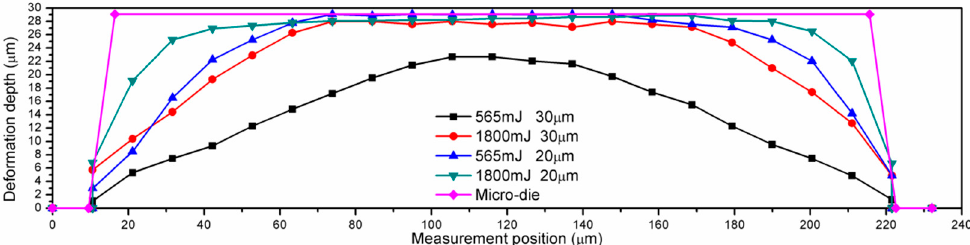
Figure 20. The experimental cross-section curves of microchannels with different thicknesses and under different laser energy.